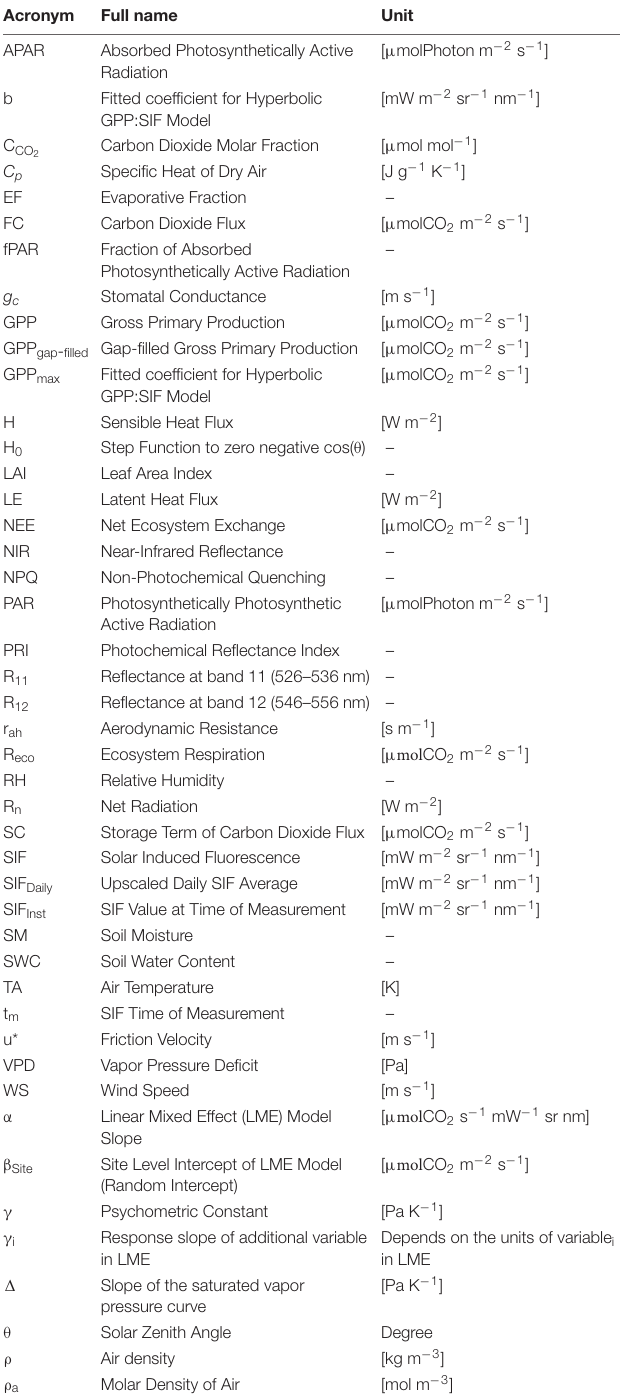
TABLE 1 | Variable names, acronym definitions, and